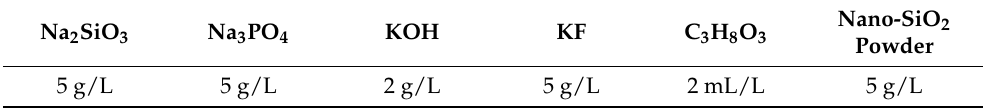
Table 2. Table showing the solution composition